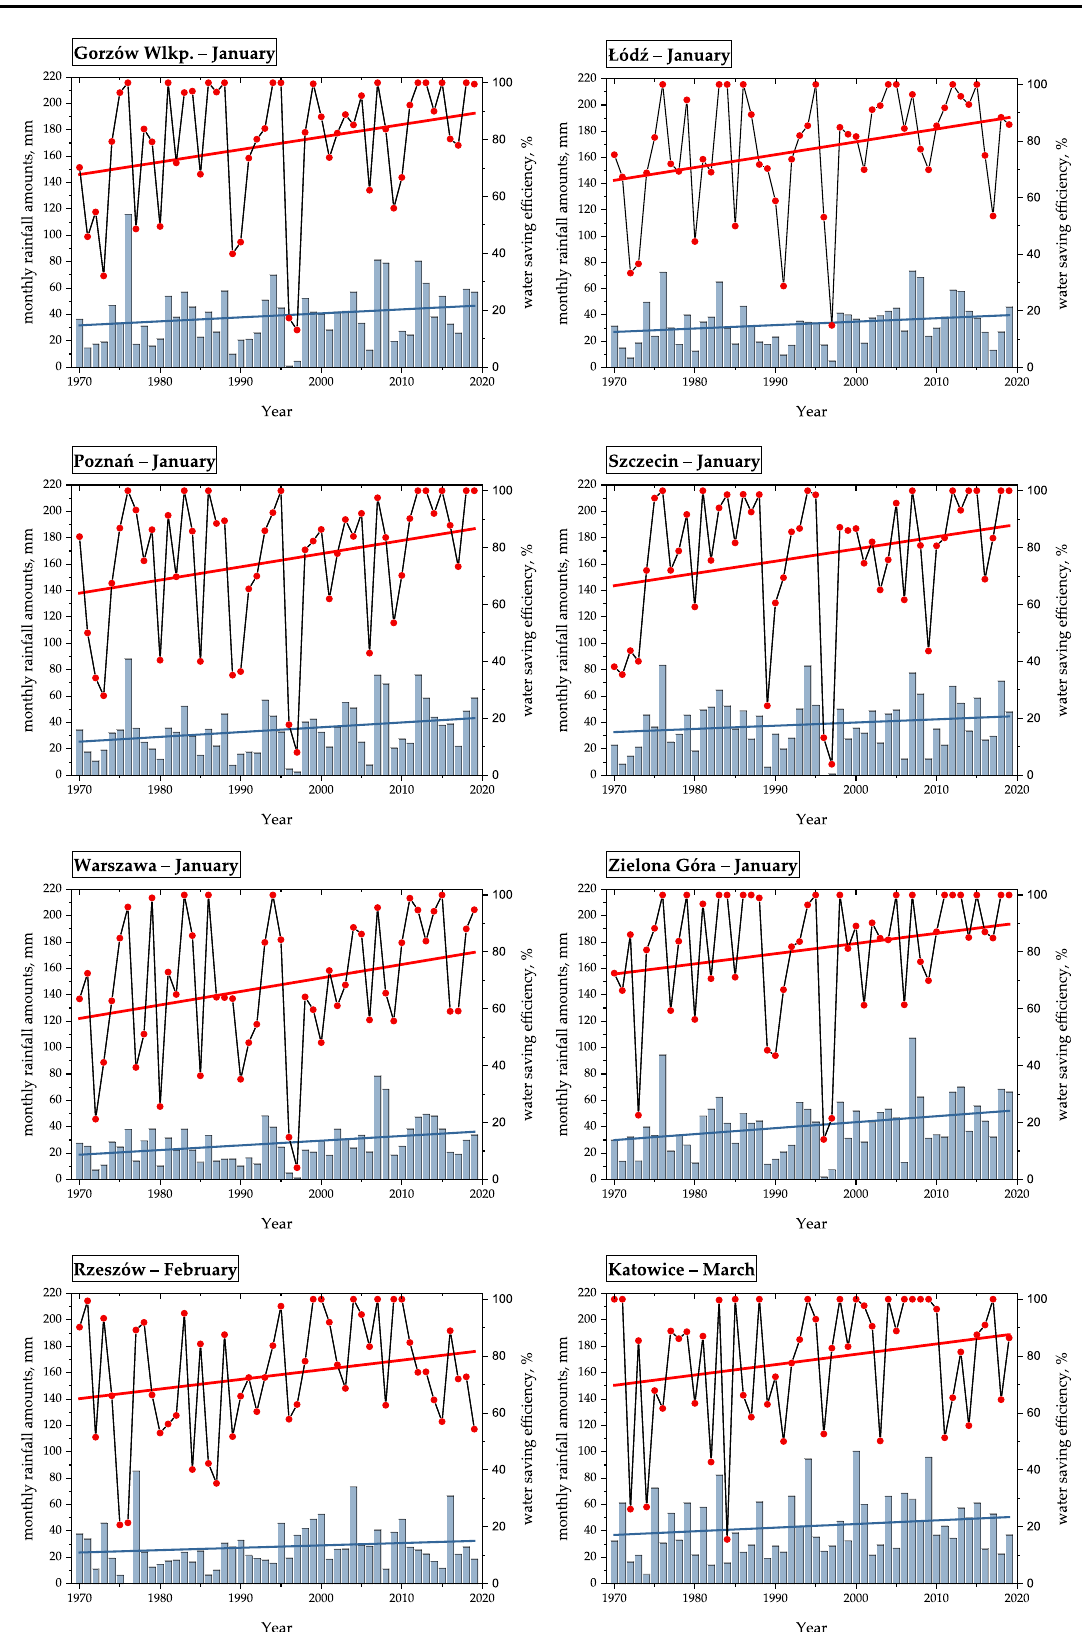
Fig. 9 Statistically significant monthly changes (red line) in water saving efficiency (red dots) in individual cities in the years 1970–2019 and monthly amounts of rainfall (blue